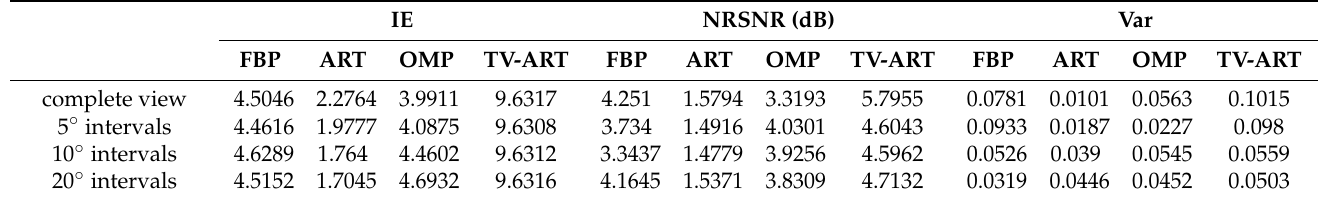
Table 4. IE, NRSNR, and Var value of different algorithms in far-field experiment.